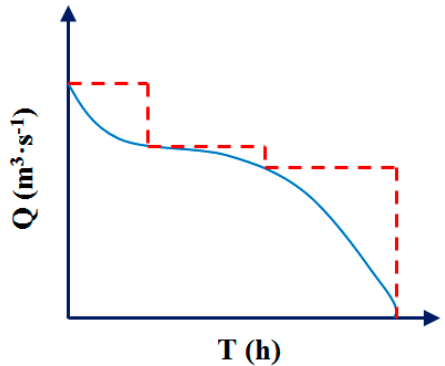
Figure 5. Water pump flux to time according to actual flow rate at different times.